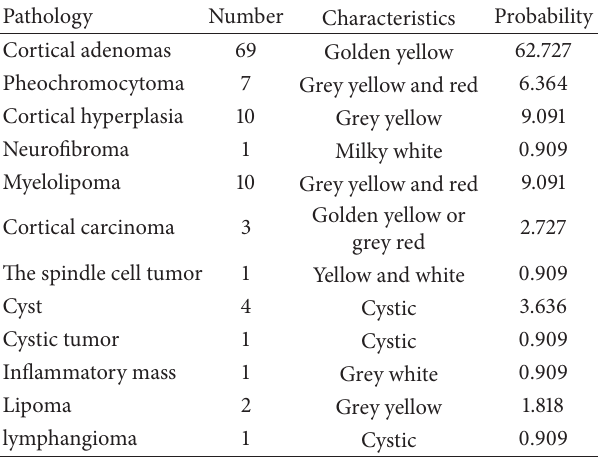
Table 2: The number, characteristics, and probability of